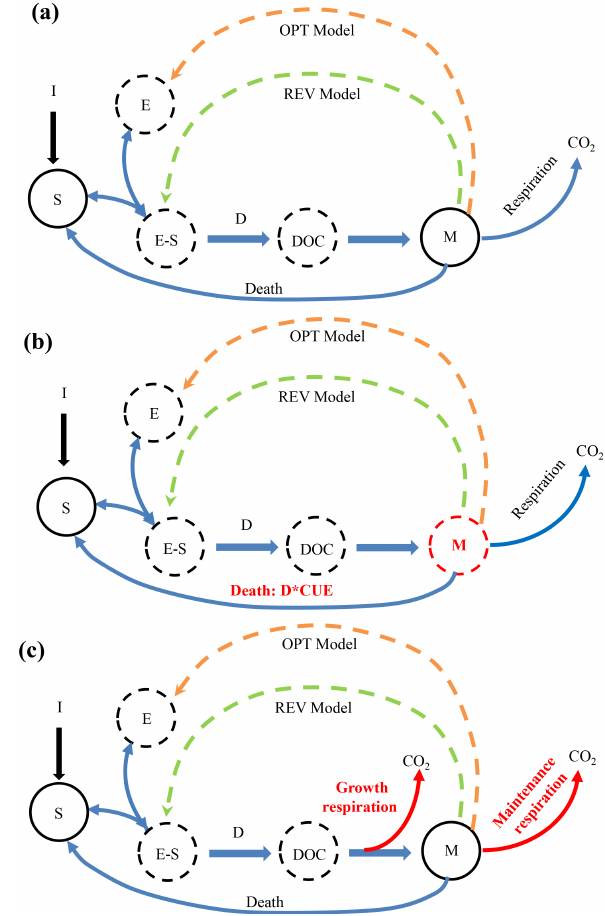
Figure 1. Conceptual diagrams of our microbial–enzyme models. The difference across the models is in the formulation of depoly- merisation of soil organic matter ( S ), where the FWD model is based on German et al. (2012), the REV model considers dimin- ishing return, and the OPT model includes optimised enzyme pro- duction to maximise microbial growth. E , S , E − S , D , DOC, and M represent enzyme, substrate, enzyme–substrate complex, depoly- merisation, dissolved organic carbon, and microbial biomass car- bon, respectively. I denotes input from fresh litter and D represents depolymerisation. Solid lines represent material (carbon) flow and dashed lines represent information flow affecting enzyme concen- tration (in microbial enzyme predation in the REV model and en- zyme production rate in OPT models). E , E − S , and DOC pools were implicitly represented in the model but not explicitly simu- lated based on the assumption of quasi-steady state. We analyse the different models in three ways: (a) comparison among different pa- rameterisations of depolymerisation (FWD, REV, and OPT mod- els); (b) a second suite of simulations operate under the assump- tion that microbes are instantaneously in steady state with substrate delivery (similar to the treatment of enzymes and DOC, for REV and OPT models only, indicated by dashed outline of the pools); (c) a third series of simulations considered partitioning between a biomass-dependent maintenance respiration and a growth respira- tion that scales to newly built tissues, applied to all (FWD, REV, and OPT)